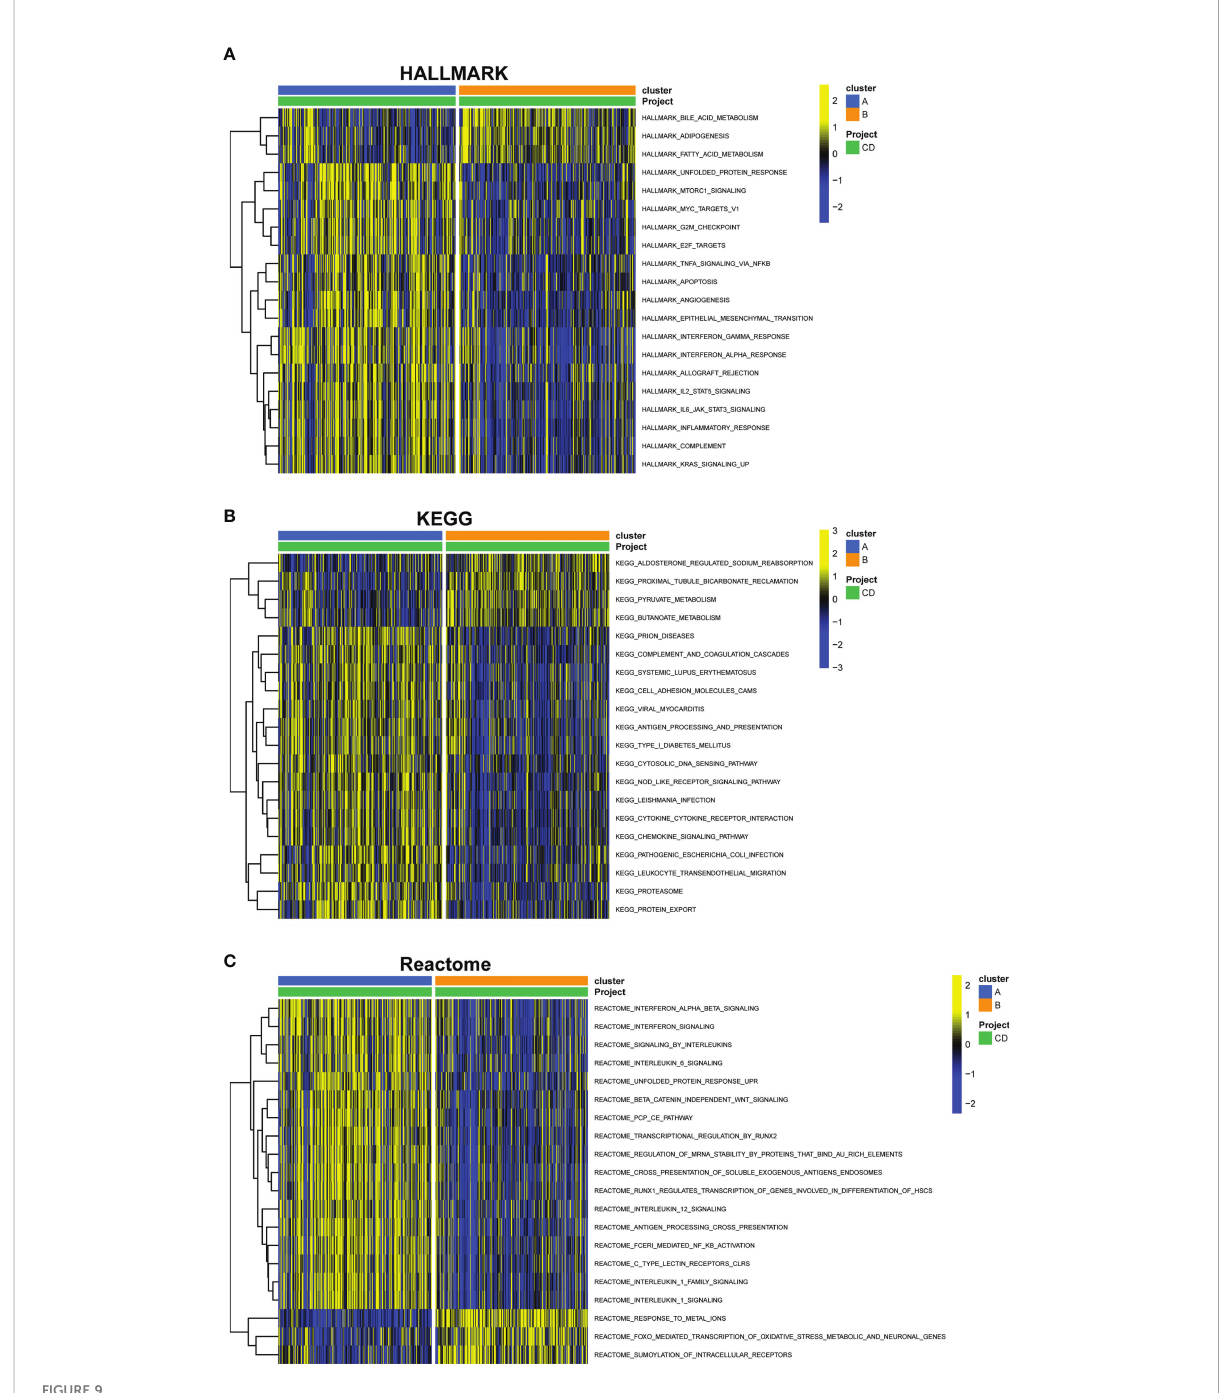
FIGURE 9 GSVA of key pathways between cuproptosis subtypes. (A) Enriched pathways based on the HALLMARK pathway. (B) Enriched pathways based on the KEGG pathway. (C) Enriched pathways based on the Reatcome pathway. GSVA, gene set variation